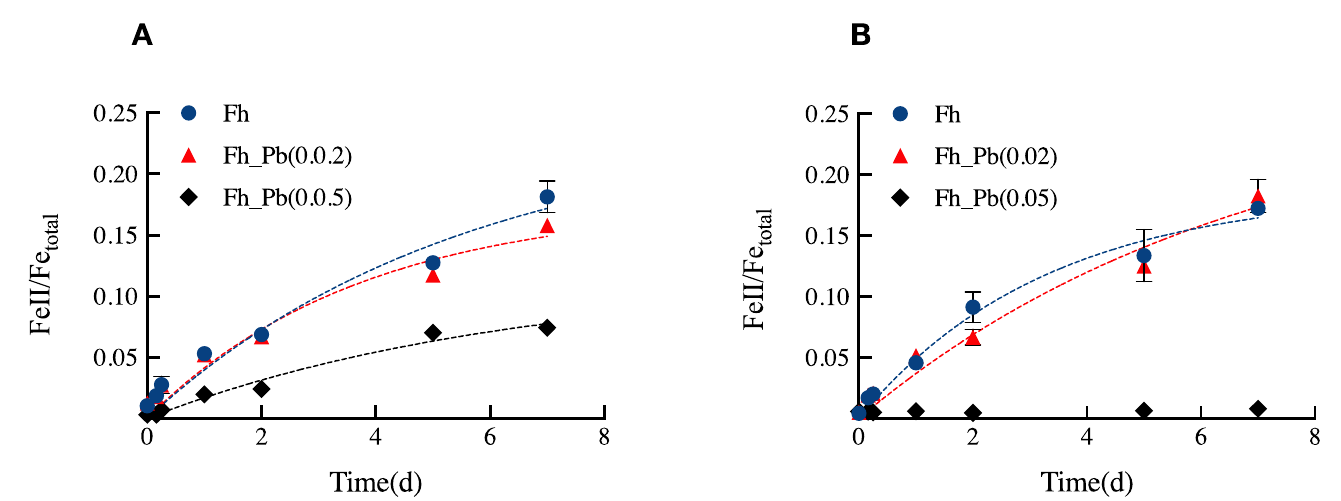
Figure 1. Concentrations of Fe(II) ions formed in the Fh, Fh_Pb(0.02), and Fh_Pb(0.05) systems during: ( A ) the RP1, and ( B ) the RP2 with Shewanella oneidensis MR-1. Error bars indicate the standard deviations of triplicate microbial-reduction assays.